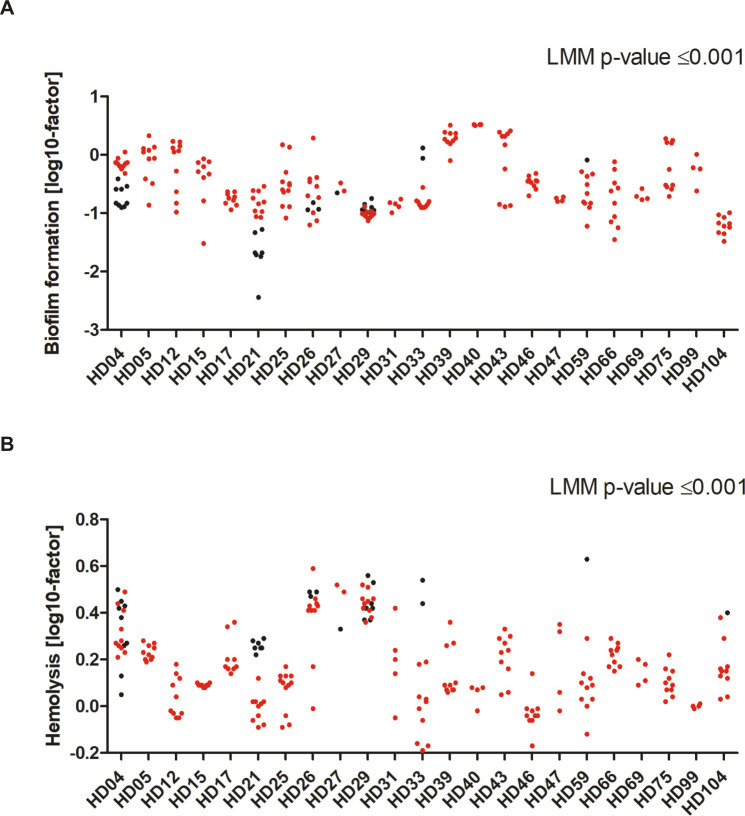
Distribution of biofilm phenotypes and hemolytic activity in invasive and commensal S. epidermidis populations metric variables (y-axis), sorted by patient (x-axis).Metric values were log transformed to attain symmetric distribution (indicated on y-axis label). Each dot represents one isolate. INF isolates are coloured in red, CloNo isolates are coloured in black. (A) Distribution of quantitative biofilm phenotypes produced in TSB. Plotted dots are means of biological duplicates. (B) Hemolysis of a 2% solution of sheep erythrocytes by supernatants of overnight cultures. Factor: extinction of free haemoglobin at 541nm in samples, normalized to hemolysis of only TSB. Plotted dots are means of biological triplicates.